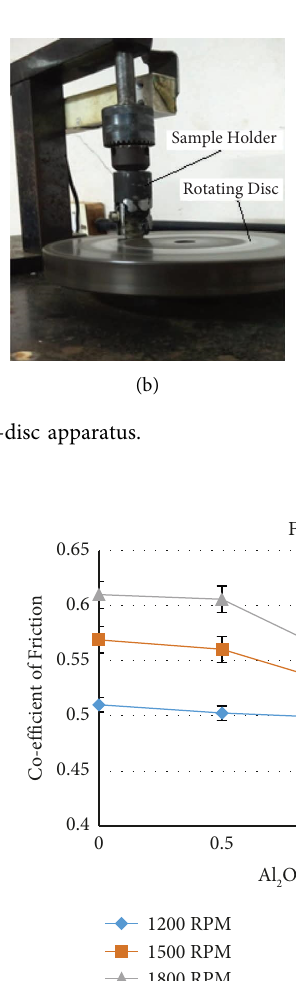
Figure 8: Coefcient of friction of epoxy hybrid composites at 20N load.